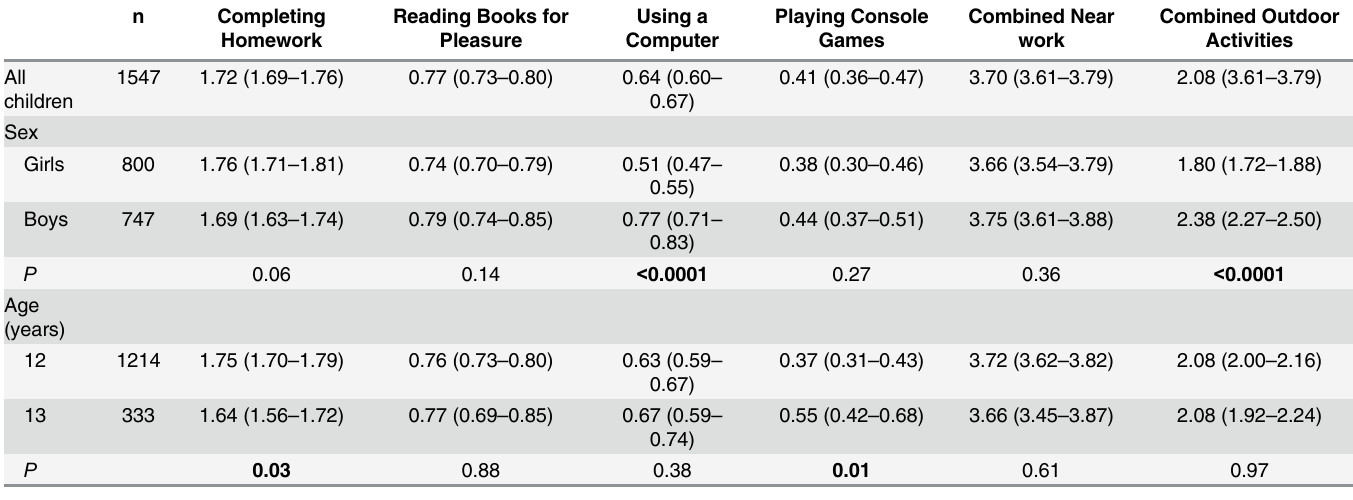
Table 2. Time spent in near work and outdoor activities (hours/day) by gender and